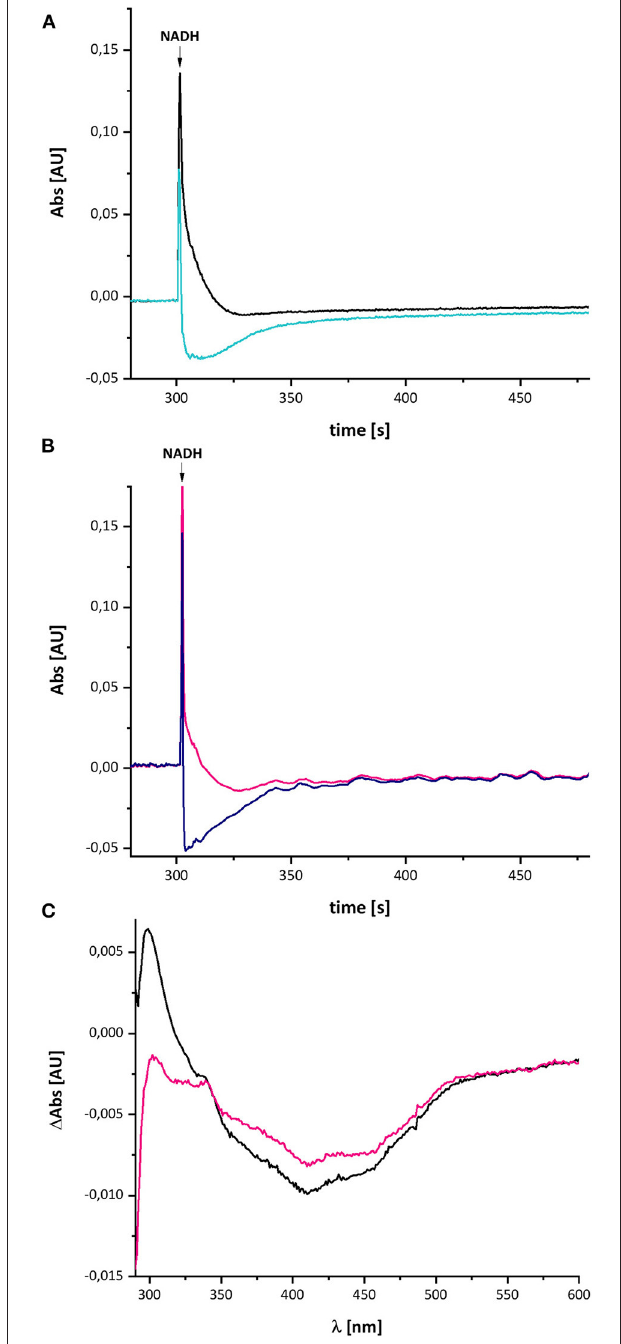
FIGURE 8 | Reduction of E. coli complex I, treated either with ethanol (A) or with piericidin A (B) , by NADH followed by partial re-oxidation by oxygen from the air. (A) The black trace shows the absorbance of NADH at 340nm and the light blue trace that of the ethanol-treated complex I at 450nm. (B) The pink trace shows the absorbance of NADH at 340nm and the dark blue trace that of the piericidin A-treated complex I at 450nm. The curves look a bit disturbed due to some dust in the cuvette. (C) Shows the (reduced-minus-oxidized) difference spectrum of the ethanol-treated (black) and the piericidin A-treated (pink) complex observed after 2min after the addition of